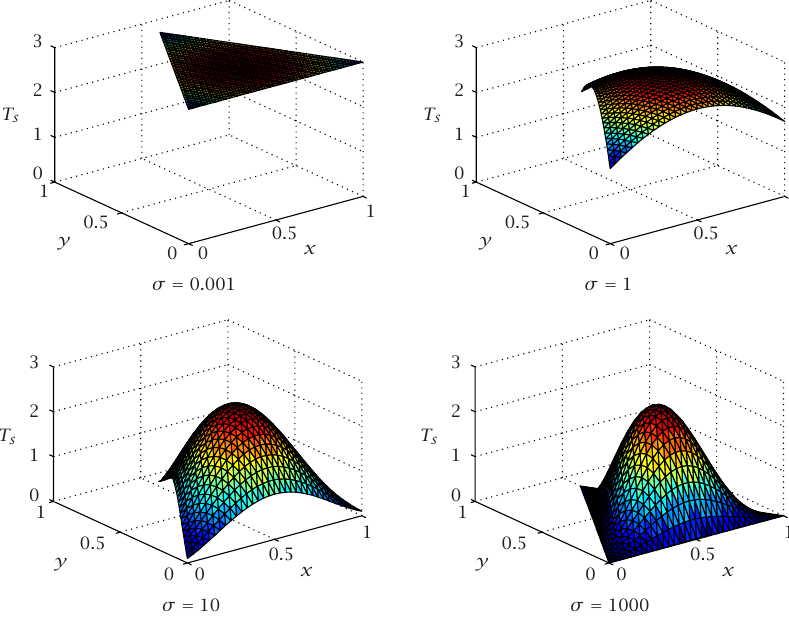
Figure 5.1 . The ( 0 , 0 ) symmetric mode.